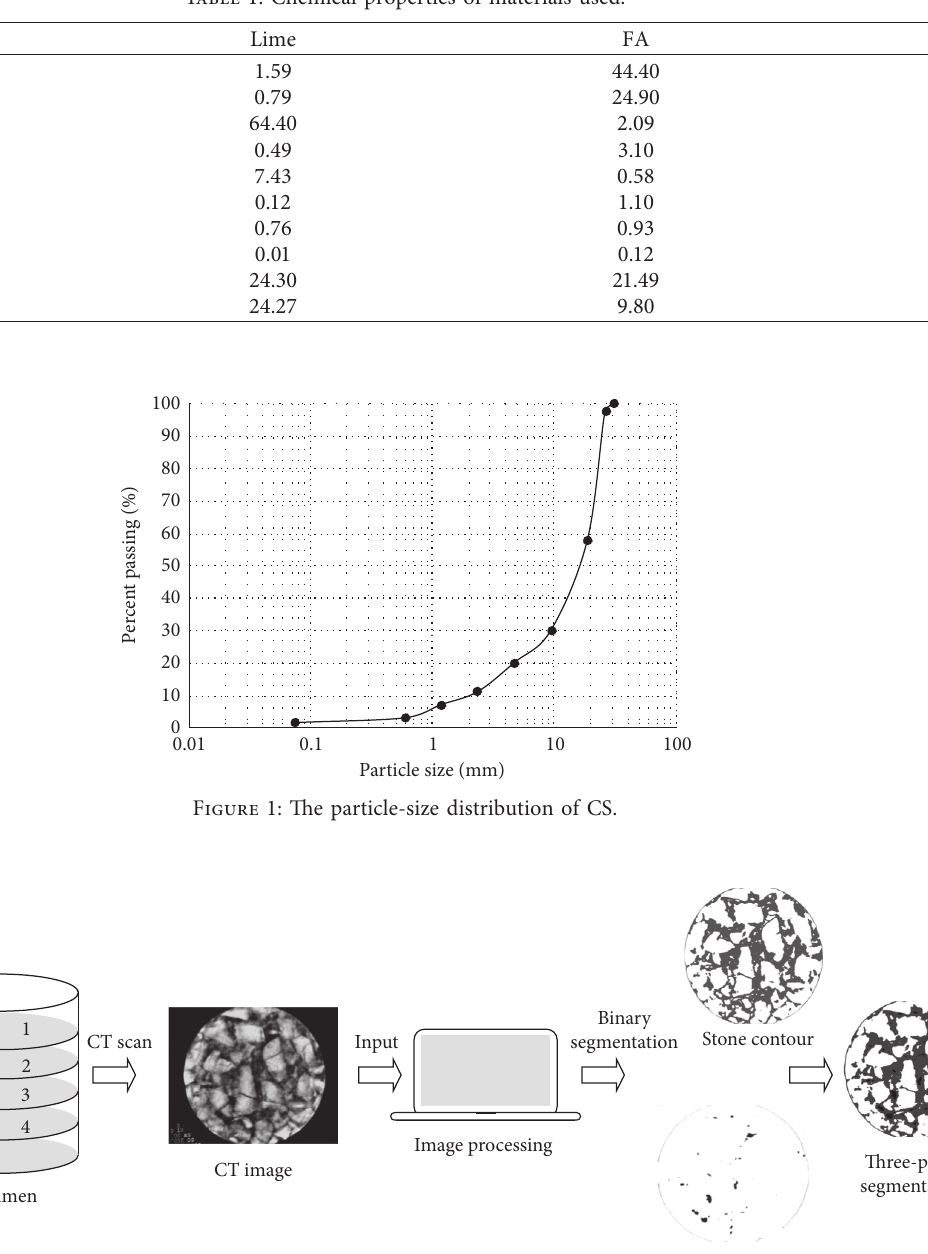
Table 1: Chemical properties of materials used.